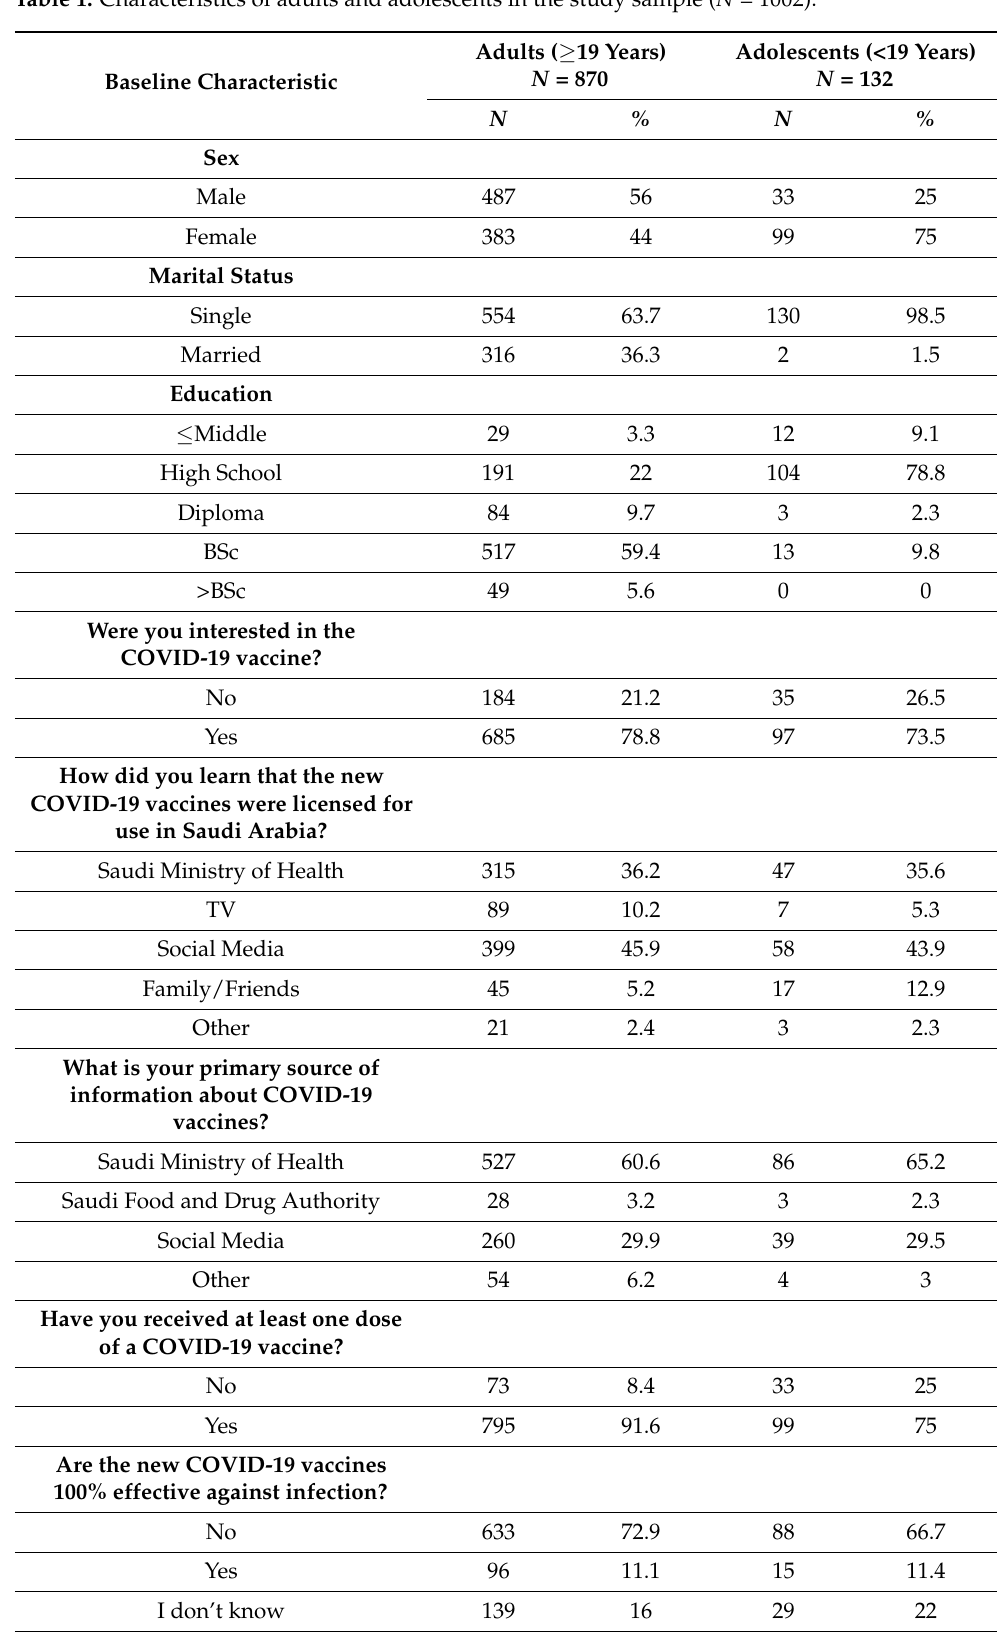
Table 1. Characteristics of adults and adolescents in the study sample ( N = 1002).